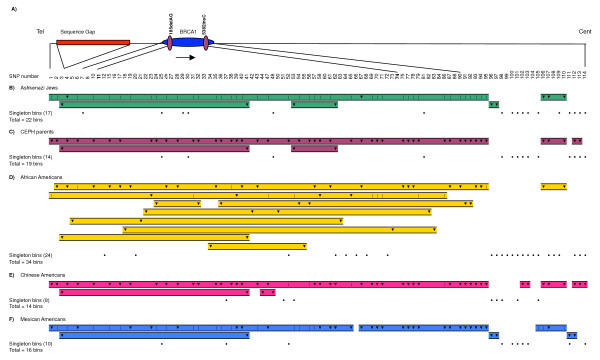
Comparison of SNP bins derived from pair-wise measurements of linkage disequilibrium using LDSelect-Comp. SNPs with MAF < 5% do not have a vertical line or arrowhead in the column. A) Scale representation of the ~650 kb region studied, indicating the BRCA1 gene, founder mutations, and genome sequence gap of unknown true size. Anchor lines link to position of the SNP within the region. B-F) LDSelect creates bins of SNPs that have an r2 value of 0.8 or greater with at least one other SNP in the bin. Each vertical line and arrowhead represents a SNP, with dashed lines and shaded background connecting SNPs within the same bin. Down arrowheads indicate Tag SNPs (those with r2 ≥ 0.8 with all other SNPs in a bin). Note that this use of the term Tag-SNP is different from Haploview – with LDSelect, only one Tag-SNP per bin would be required to capture the majority of the nucleotide diversity. Singleton bins (SNPs that did not have r2 ≥ 0.8 with any other SNP) are indicated by solid dots on a single row. SNP number refers to numbering in column 1 of Table 1.